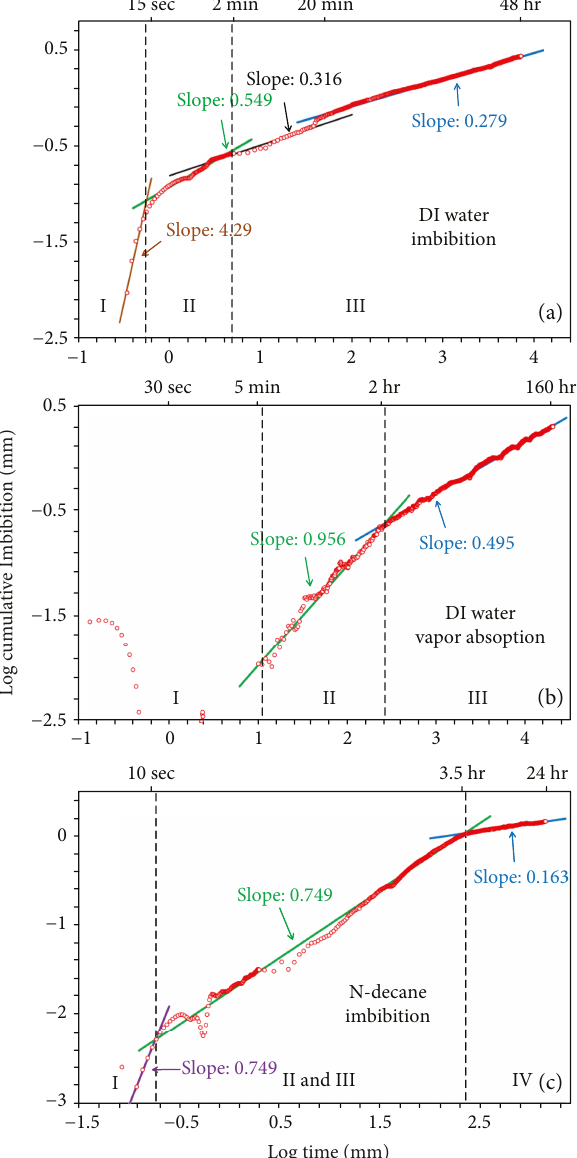
Figure 7: Fluid imbibition ((a) DI water, (c) n-decane) and vapor absorption ((b) DI water) results for sample B-13010. Di ff erent phases of fl uid uptake are indicated with vertical